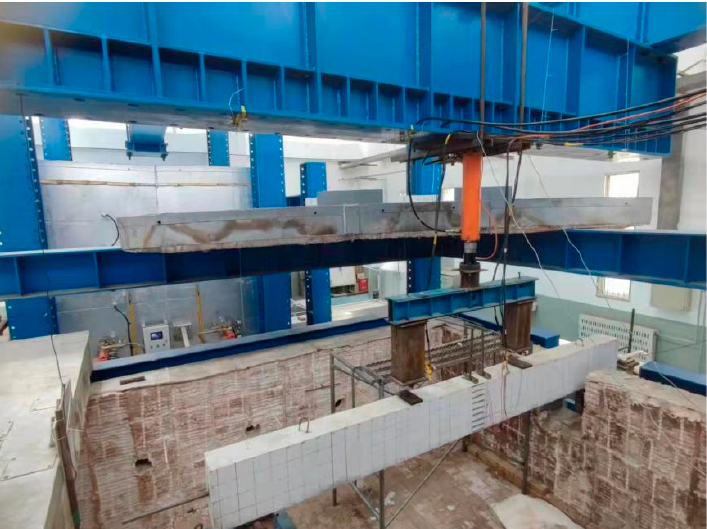
Figure 3. A full view of test equipment.